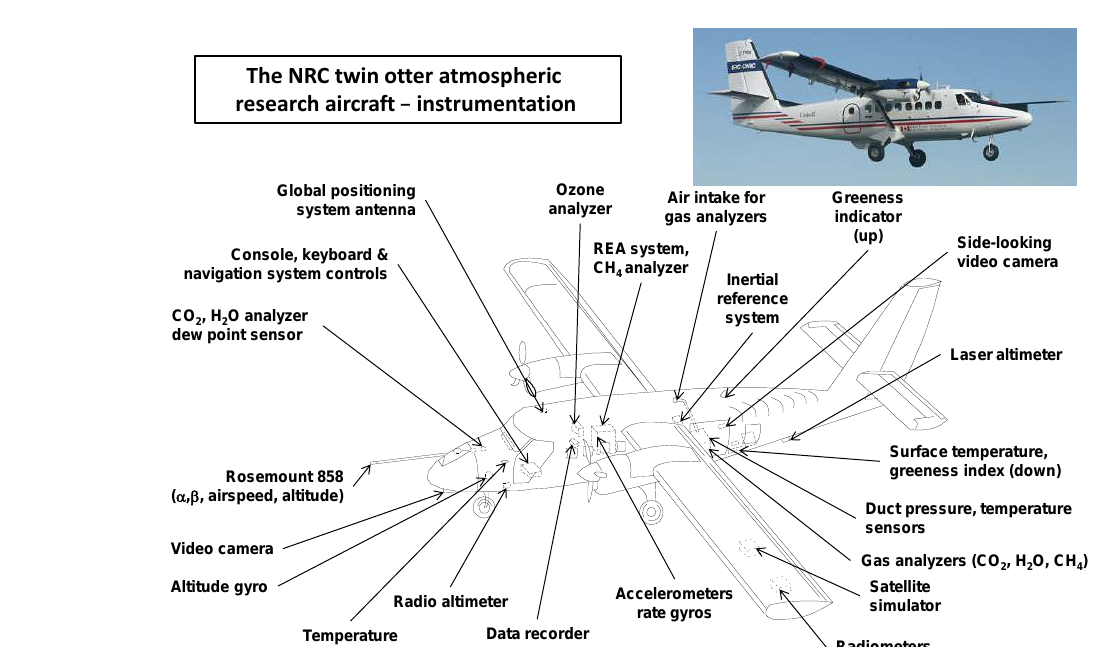
Figure 1. Instrumentation on-board the NRC Twin Otter, 1987–2011. Actual instrumentation varied slightly by measurement campaign.